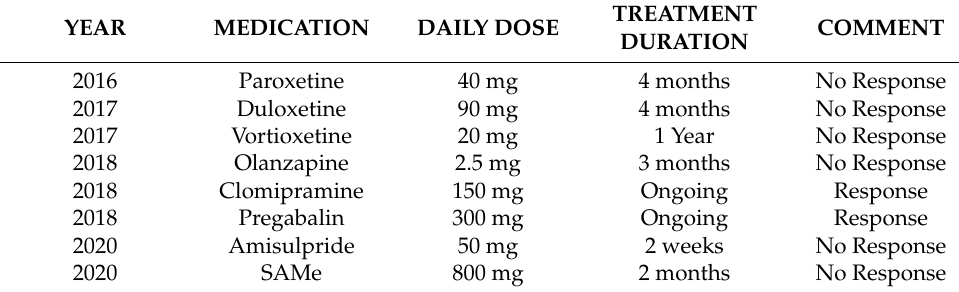
Table 1. Treatment